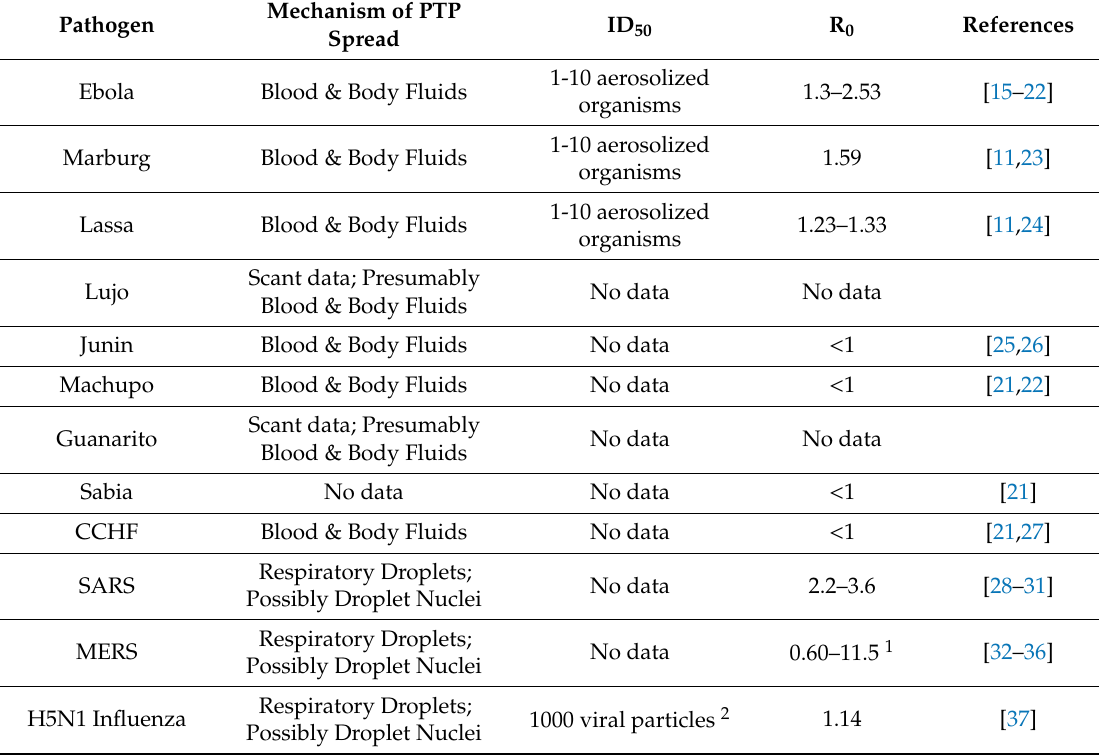
Figure 1. Construct used in determining diseases warranting care in a high-level containment care unit. Table 1. ID 50 and R 0 data for putative HLCC pathogens.